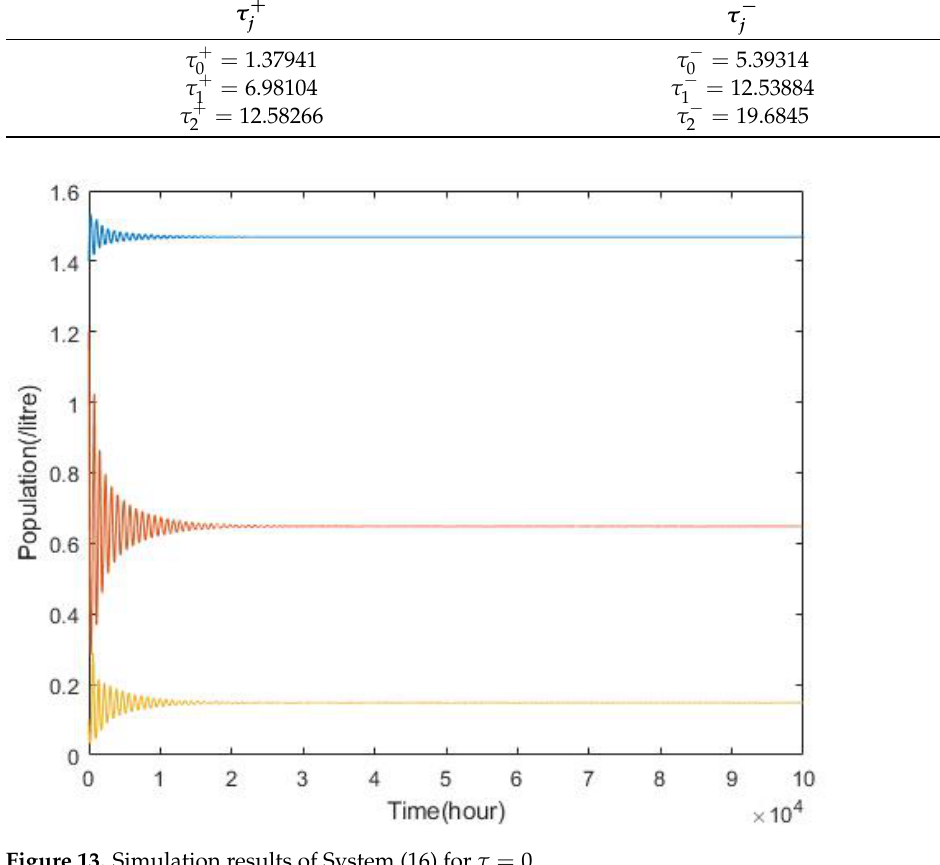
Figure 13. Simulation results of System (16) for τ = 0.